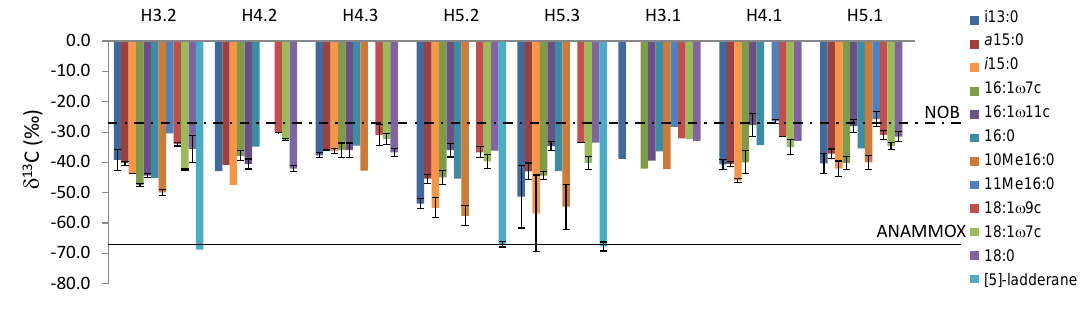
Figure 7. PLFA δ 13 C values averaged in the different wells for June, September and December. The dotted and full lines represent the δ 13 C values of 11Me16:0 and ladderanes associated with nitrite-oxidizing bacteria (e.g. Nitrospira moscoviensis ) and anammox bacteria, respectively.